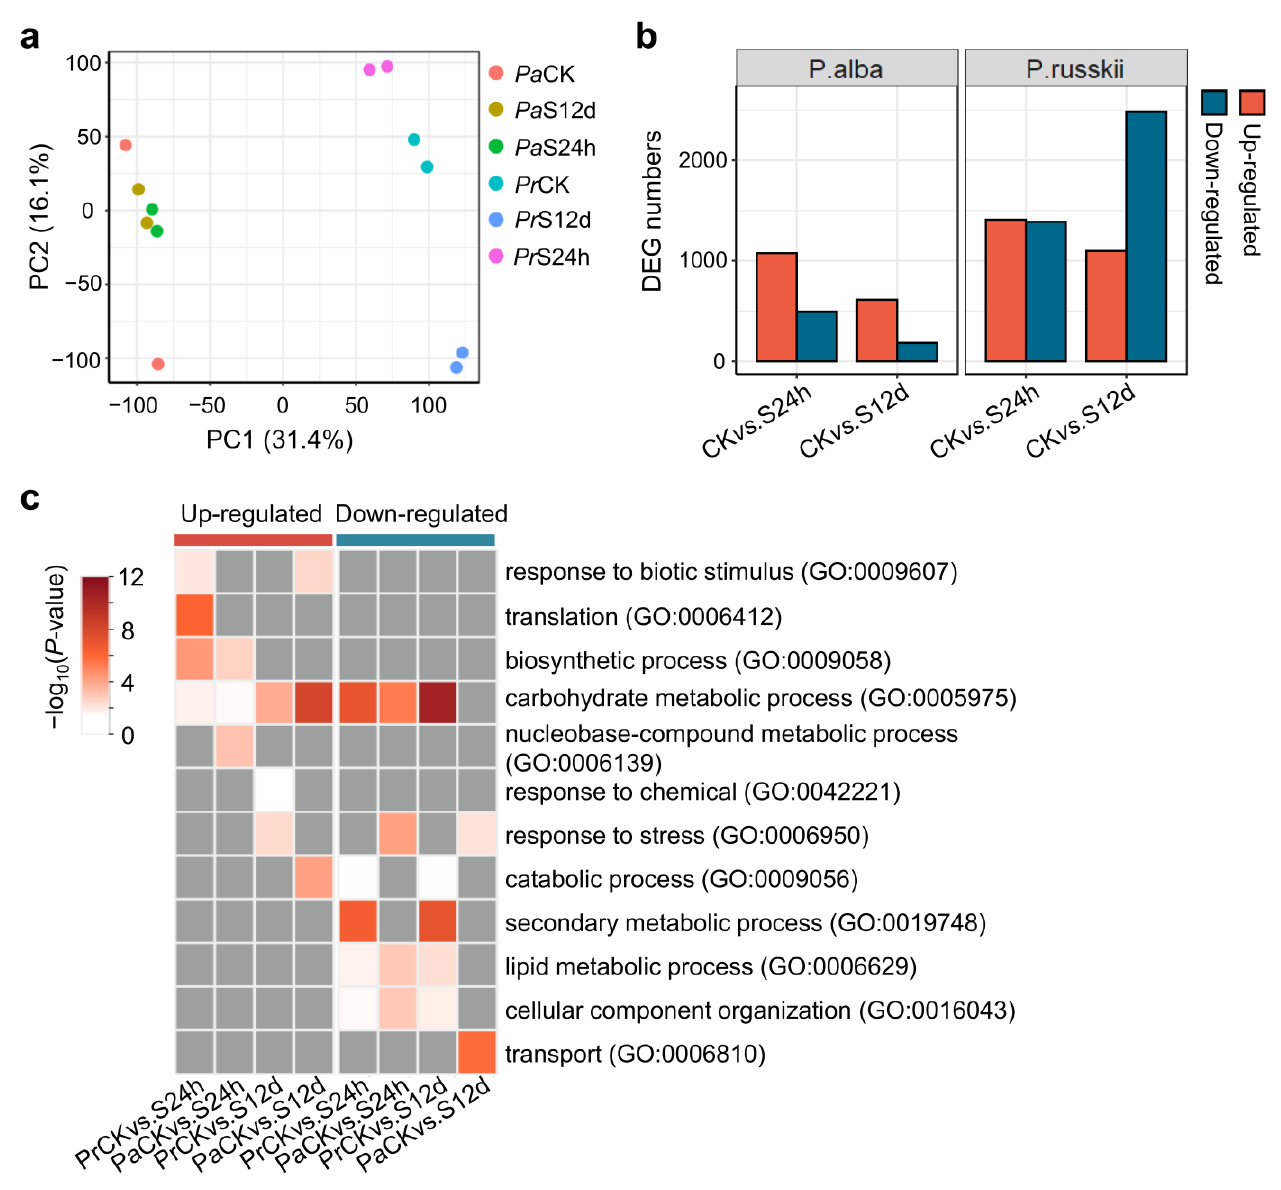
Figure 3. Differentially expressed genes (DEGs) identified in root of P. alba and P. russkii under salinity stress. ( a ) PCA analysis of the transcriptome data. ( b ) DEG numbers of the identified in P. alba and P. russkii under NaCl treatment for 24 h and 12 d versus to the control (CK), respectively. ( c ) GO enrichment of the up- and down-regulated genes identified in P. alba and P. russkii under NaCl treatment for 24 h or 12 d. Grey color indicates not available.